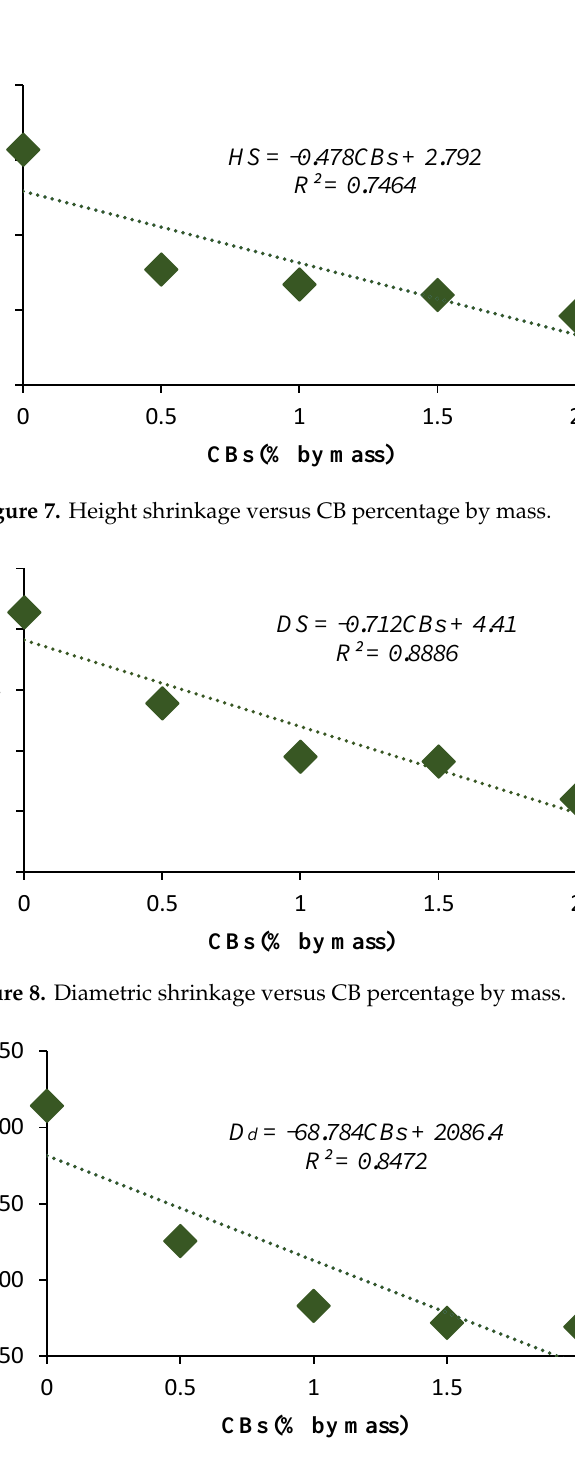
Figure 9. Dry density versus CB percentage by mass.